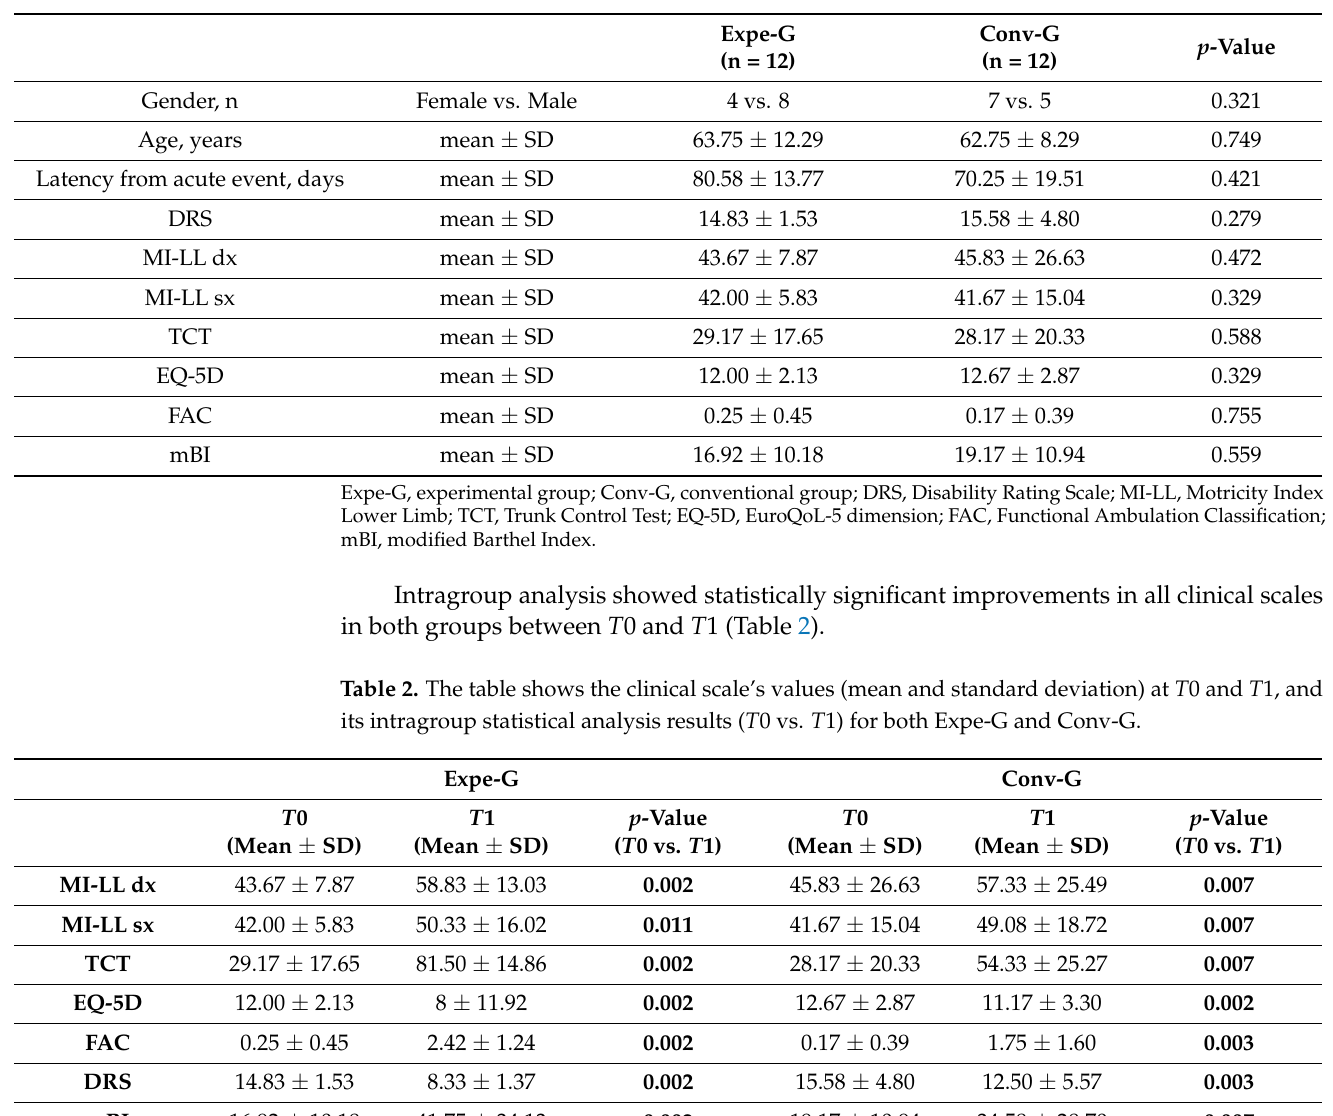
Table 1. Characteristics of the population at